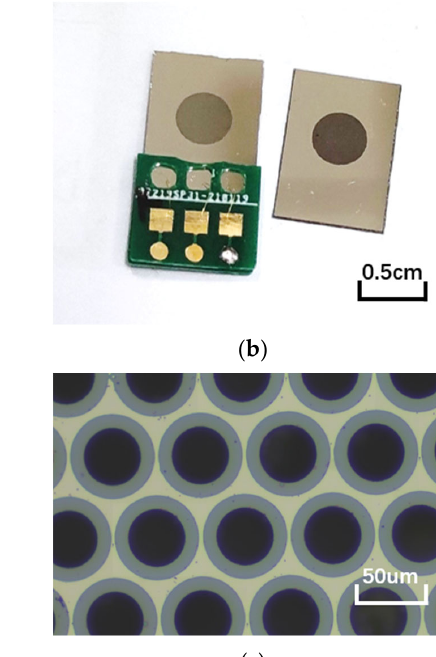
Figure 4. Manufacturing process of sensitive electrode. ( a ) Manufacturing process of sensitive elec ‐ trode based on a micro ‐ electro ‐ mechanical system. ( b ) The finished electrode (right) and the elec ‐ trode after pasting PCB (left). ( c ) Microscopic observation of flow holes in sensitive electrodes.